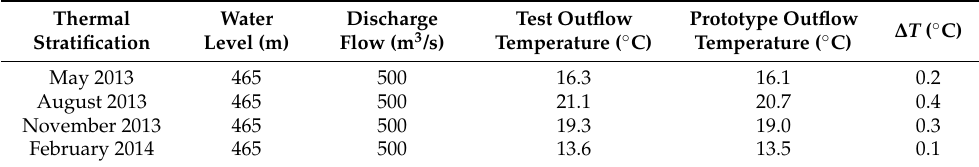
Table 4. Comparison of outflow temperature between test measurement (after conversion) and prototype